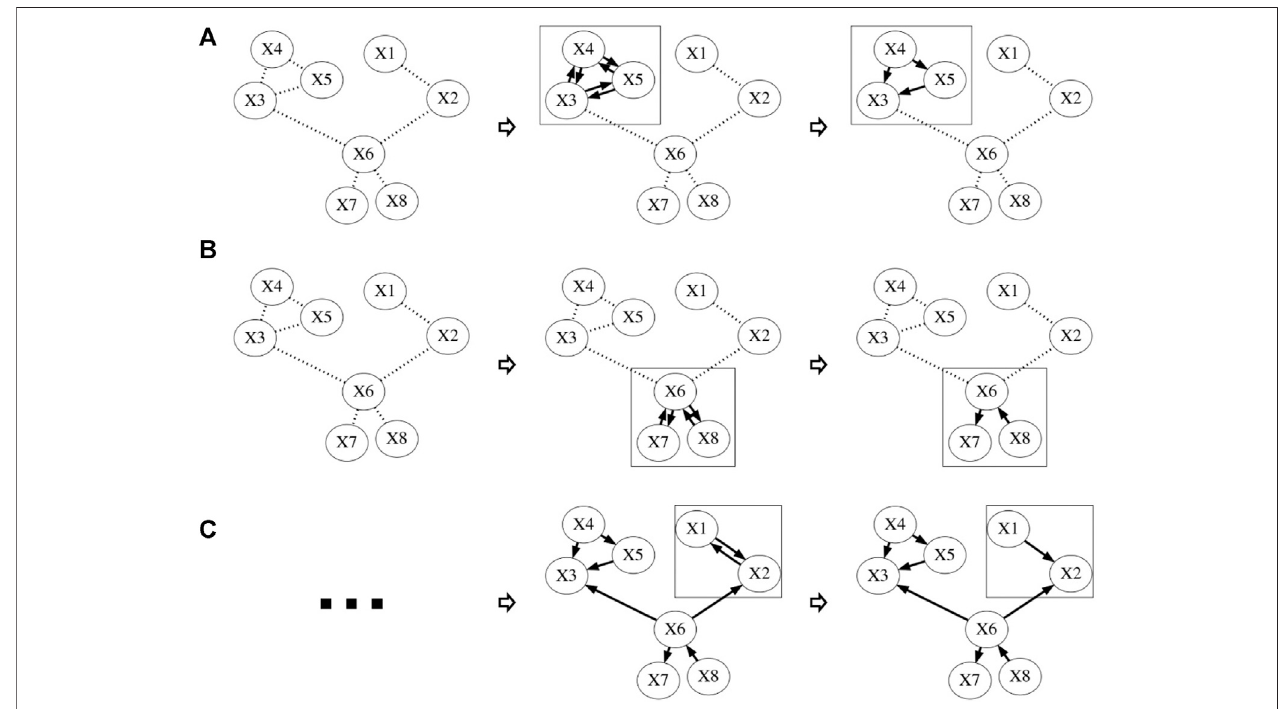
FIGURE 1 | Structure discovering